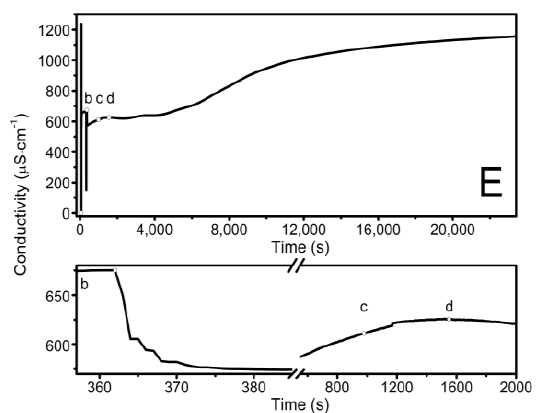
Figure 2. Conductivity in the reaction systems of P1 ( A ), P2 ( B ), P3 ( C ), P4 ( D ), and P5 ( E ) observed over time, over the course of synthesis at T = 70 °C. Point (a) determines the moment of the addition of the initiator — APS, point (b) determines the addition of the aqueous solution of the monomers — NIPA and appropriate PEGMEMs, point (c) determines the beginning of the visible change in the cloudiness of the reaction mixture, point (d) determines the complete turbidity of the reaction mixture.